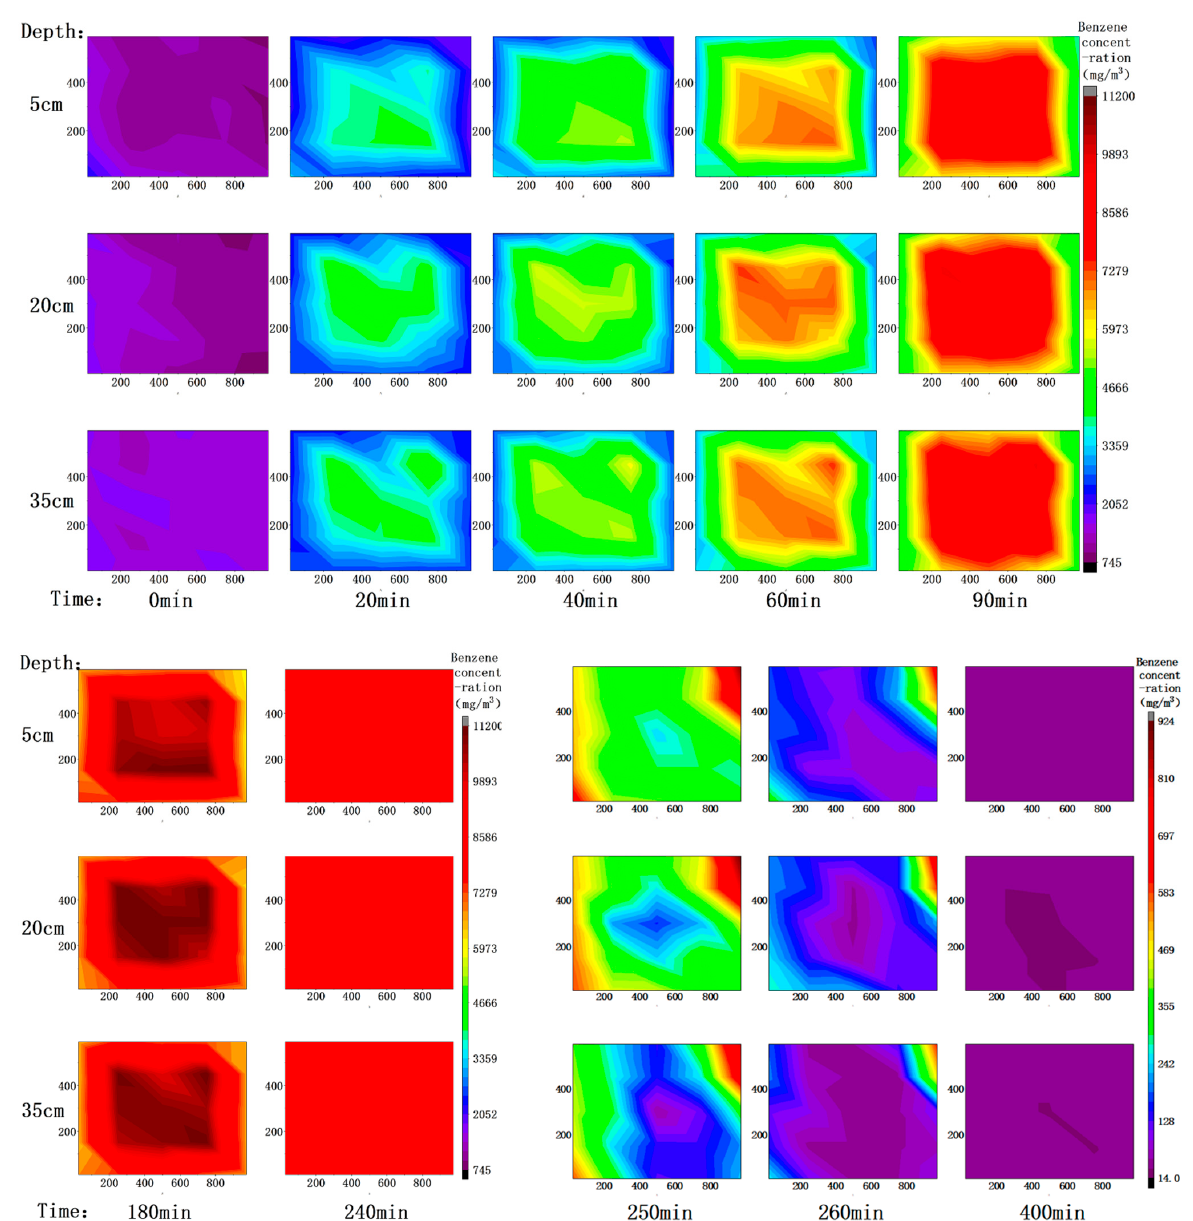
Figure 3. Contour map of soil gas benzene concentration at 0, 20, 40, 60, 90, 180, 240, 250, 260, and 400 min.